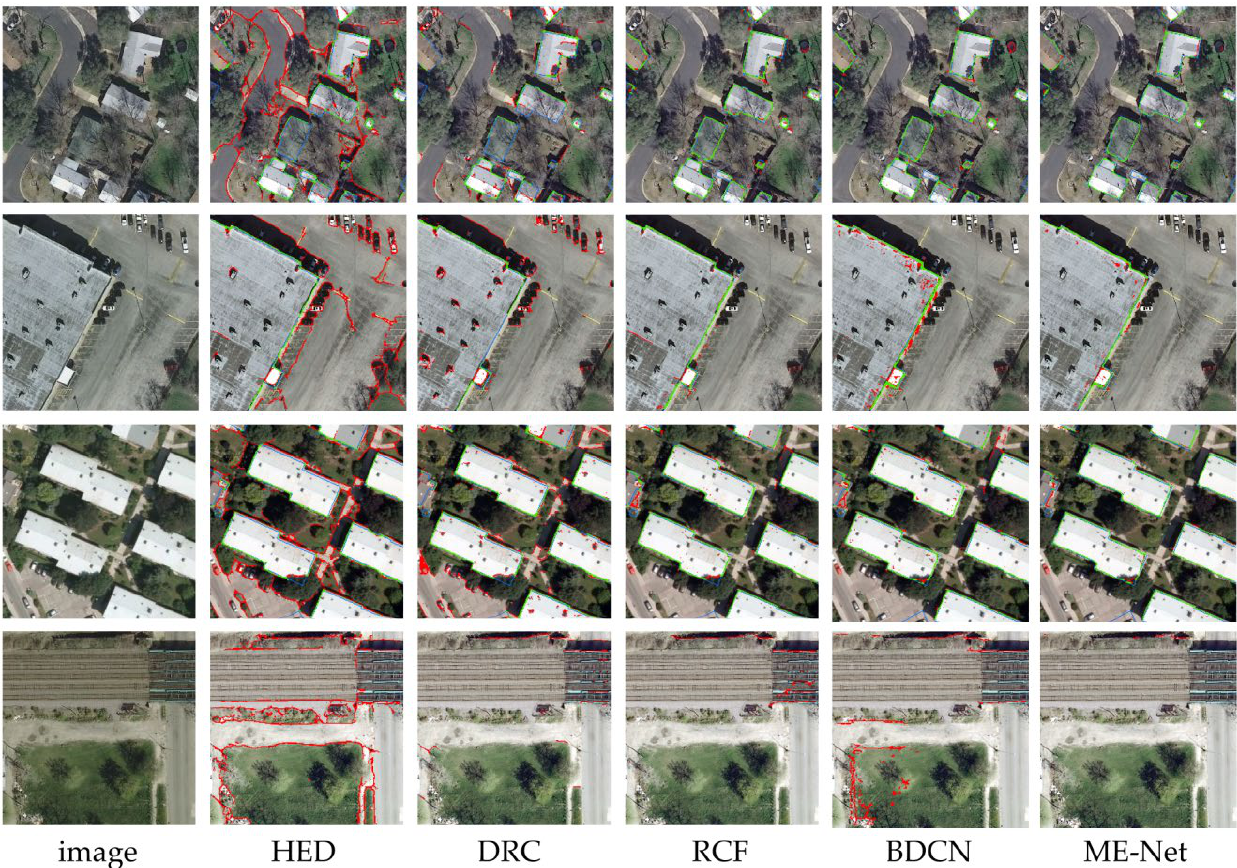
Figure 11. Image samples and final results generated by HED, DRC, RCF, BDCN and our proposed ME-Net after NMS. The green, red, blue, and background pixels in the results represent true positive, false positive, false negative and true negative predictions, respectively.